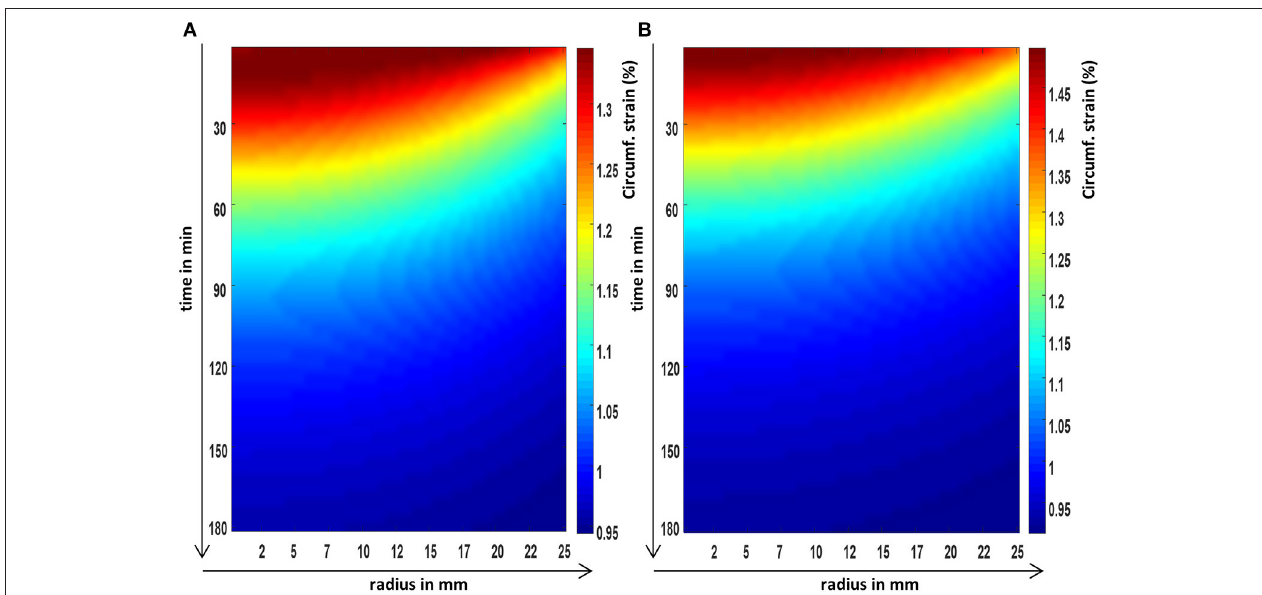
FIGURE 5 | The FEM predictions of the circumferential strain evolution over time, at the axial center, and across the radius of a cylindrical poroelastic sample subjected to a constant axial stress (A) and an equivalent constant axial strain (B) .